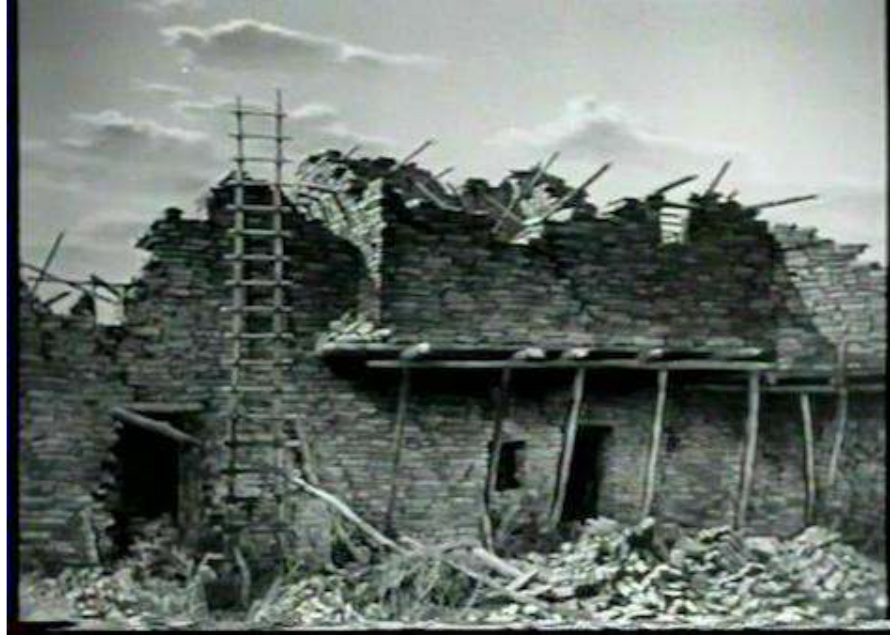
Figure 12: Ruins in Colorado